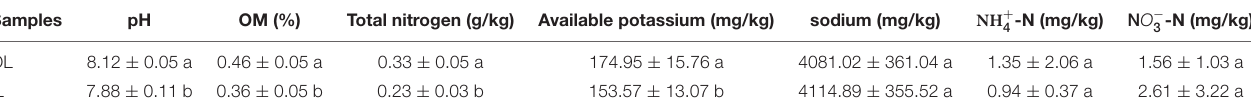
TABLE 1 | Physicochemical parameters measured for the sample sites in Qilianyu lagoon and surrounding areas.